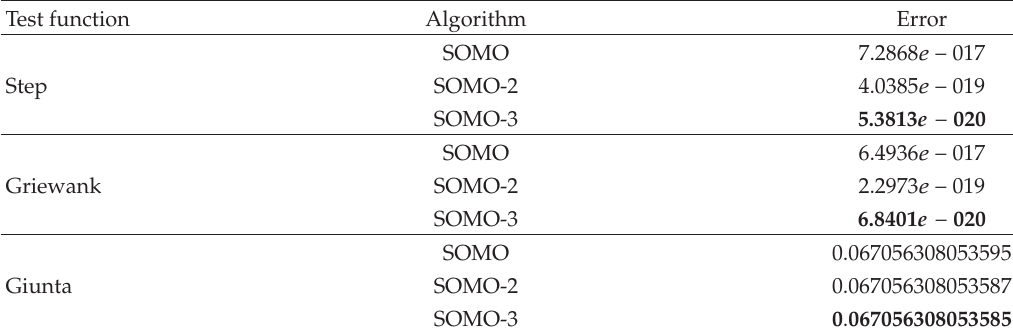
Table 3: Error of SOMO, SOMO-2, and SOMO-3.